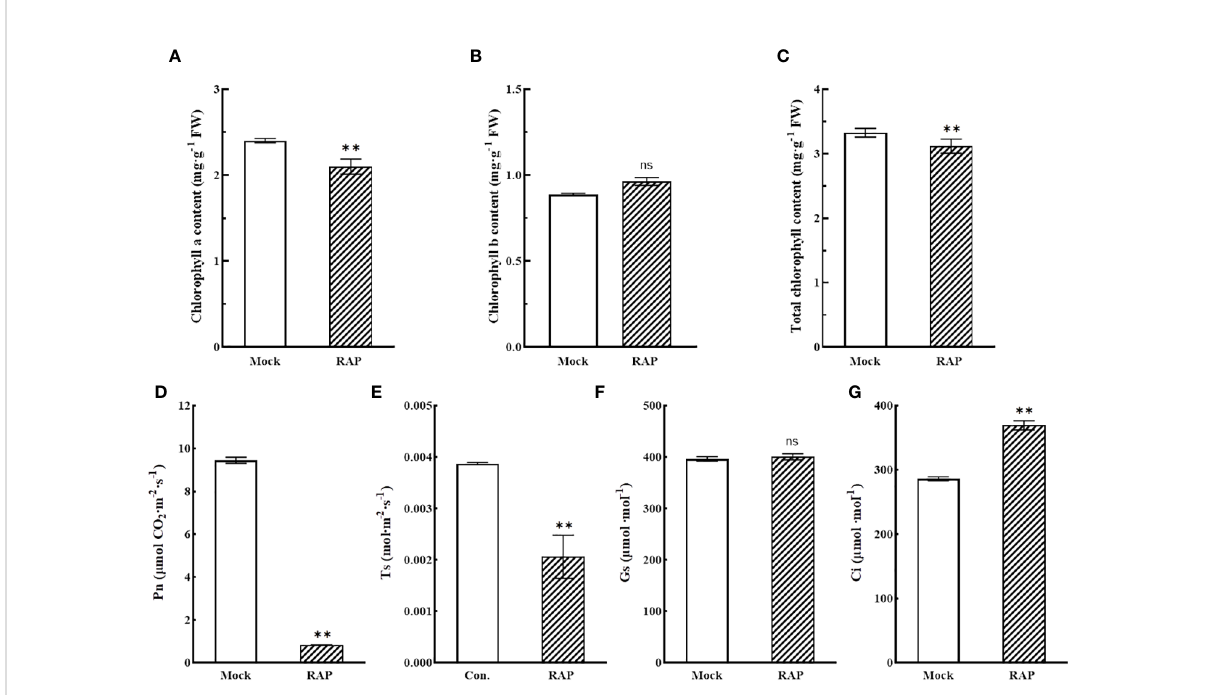
FIGURE 5 Changes in chlorophyll contents and photosynthetic indexes in leaves of tomato seedlings treated with RAP. (A) Chlorophyll a content in tomato leaves after RAP treatment. (B) Chlorophyll b content in tomato leaves after RAP treatment. (C) Total chlorophyll content in tomato leaves after RAP treatment. (D) Net photosynthetic rate in tomato leaves after RAP treatment. (E) Transpiration rate in tomato leaves after RAP treatment. (F) Stomatal conductance in tomato leaves after RAP treatment. (G) Intercellular carbon dioxide concentration in tomato leaves after RAP treatment. Errors are standard deviations for three biological